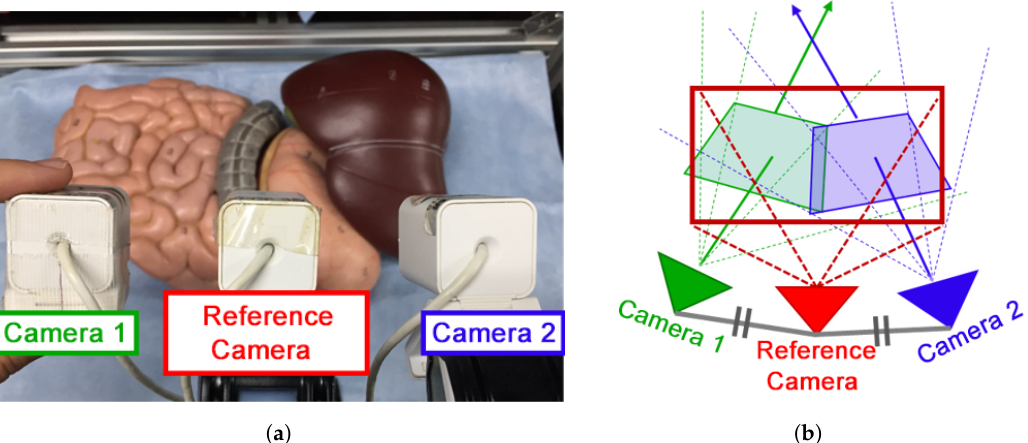
Figure 12. Experimental setup for presentation methods evaluation: ( a ) experiment environment (human model); ( b ) cameras’